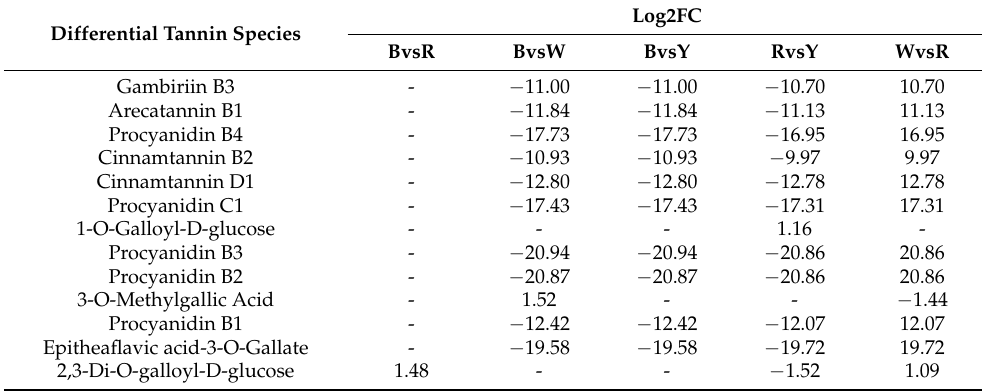
Differential Tannin